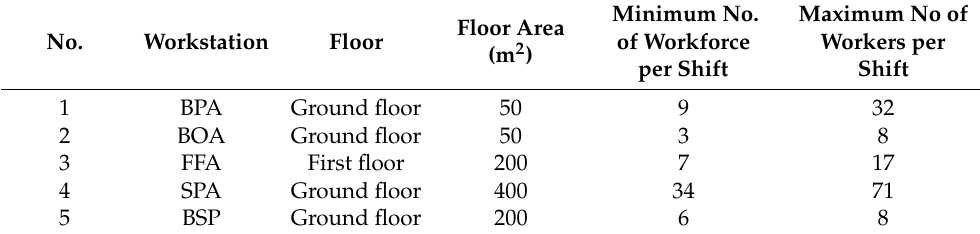
Figure 3. Sketched Layouts of the Workstations. Table 1. Information of the Monitored Workstations